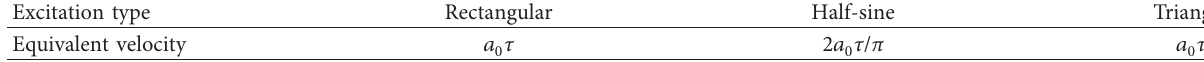
Table 4: Relationships between the equivalent velocity and acceleration pulse.